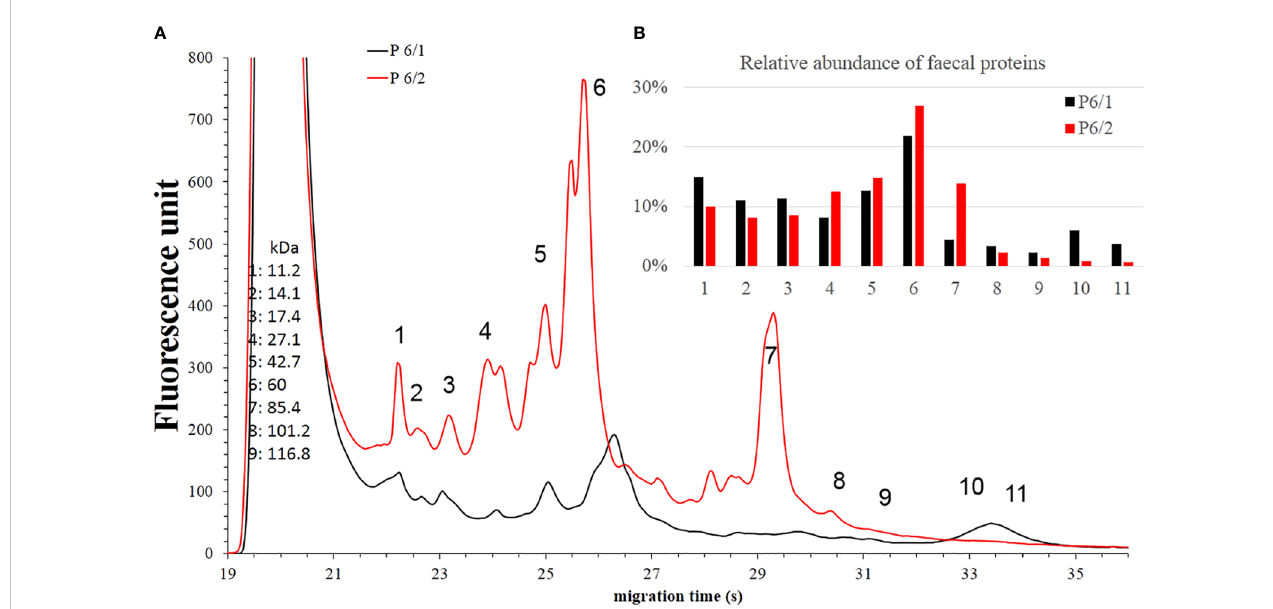
FIGURE 8 Faecal protein analysis (A) and relative abundance of faecal proteins (B) of Patient #6 before (black) and after (red) FMT. The numbered data points refer to different components. The molecular weights of the components can be seen on the left side in kilodaltons. Panel b shows the relative abundance of